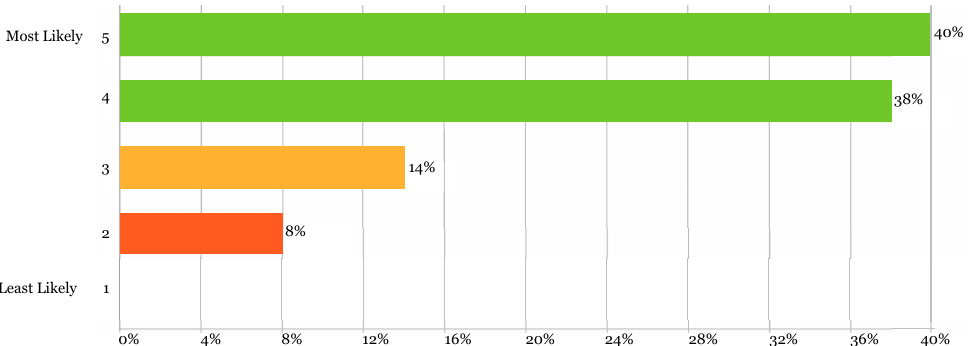
Figure 12. Showing results of exit survey Q2: On a scale from 1–5, how likely can LPs provide you with inspiration for innovative ideas? Data were scored as 4–5 = positive (green), 3 = ambivalent (orange), 1–2 = negative (red).